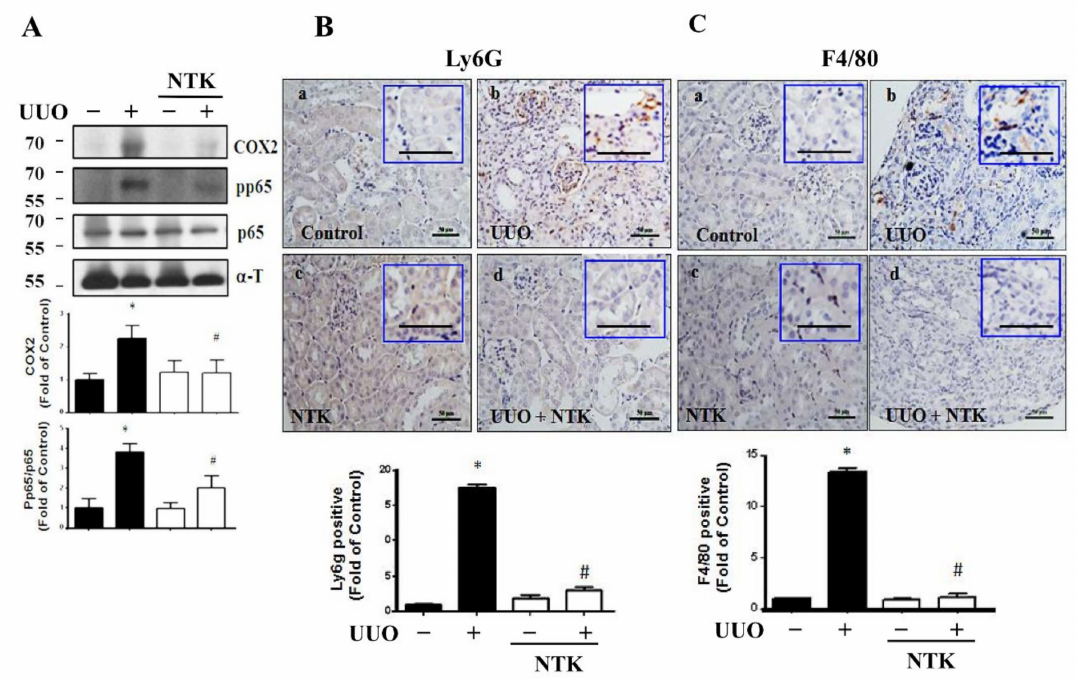
Figure 6. Effects of Nootkatone on the inflammatory cell infiltration in the UUO kidneys. Vehicle or Nootkatone (NKT) was orally given to the sham or UUO mice for 14 days. Protein expression levels of pro-inflammatory signaling molecules were determined by Western blotting ( A ). The changes in the protein expression of both neutrophil marker Ly6G and macrophage marker F4/80 by IHC are shown in ( B , C ), respectively. a, Control; b, UUO; c, NTK; d, UUO+NTK. Scale bar: 50 µ m. Data are presented as mean ± SD ( n = 6). * p < 0.05 vs. the sham control group. # p < 0.05 vs. the UUO group. α -T: α